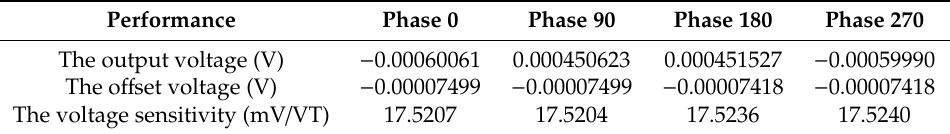
Table 2. The offset voltages and voltage sensitivity of the orthogonal coupled structure.